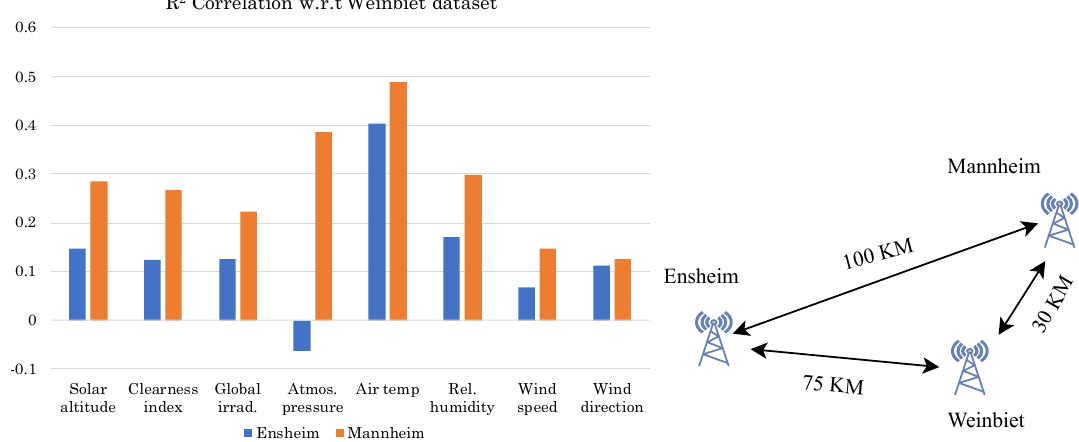
Figure 2. Comparison of the Ensheim and Mannheim datasets with respect to the Weinbiet dataset (also relative positions of weather stations).